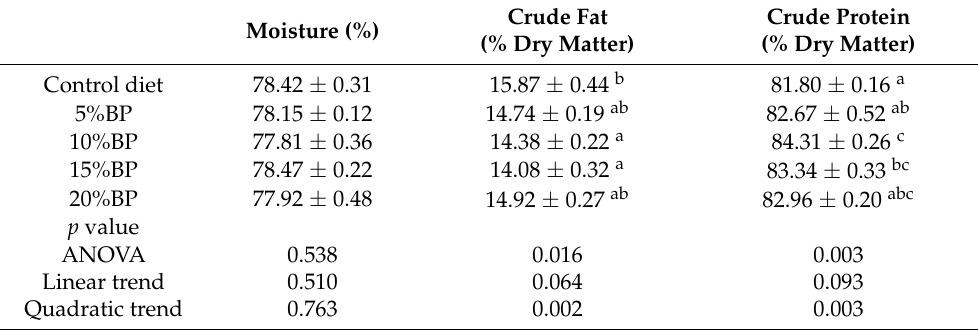
Table 4. Muscle nutritional component of grass carp fed a diet with paper mulberry (BP) for 8 weeks. Crude Fat Crude Protein Moisture (%) (% Dry Matter) (% Dry Matter) Control diet 78.42 ±